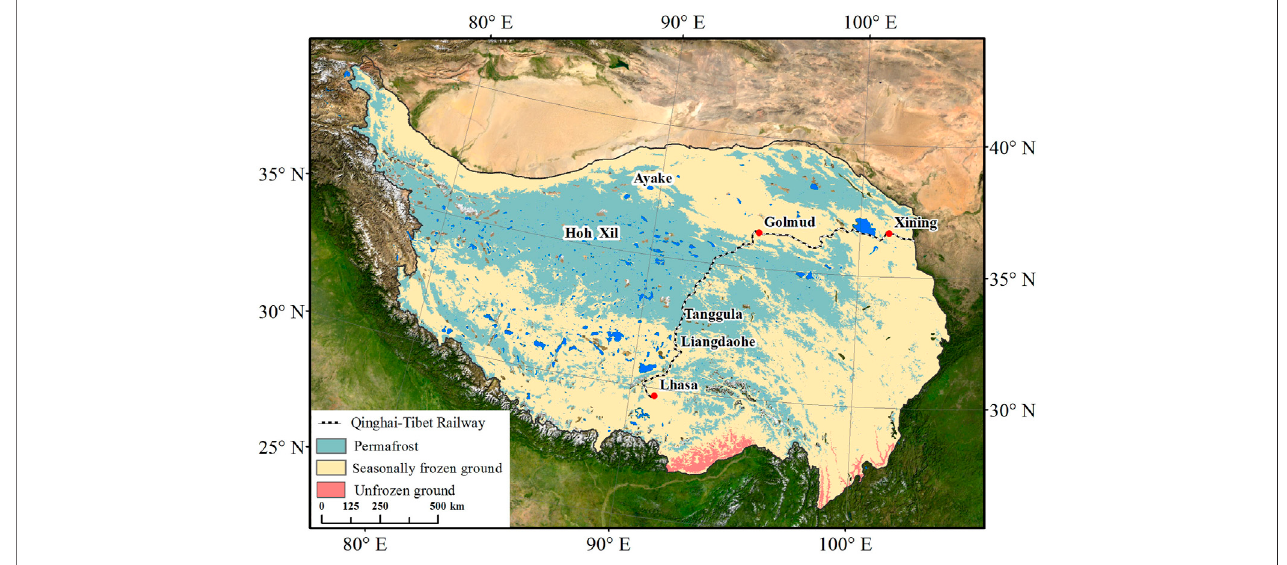
FIGURE 1 | The location of the study